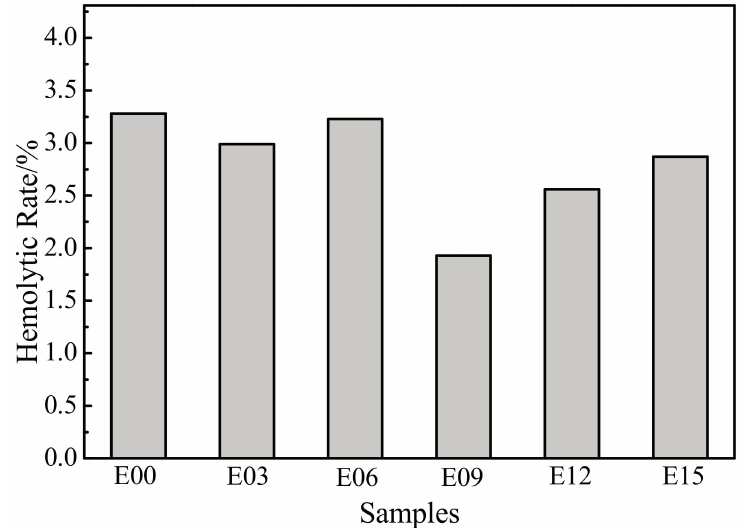
Figure 10. Hemolysis rate of samples. E00: substrate; E03: 3 min; E06: 6 min; E09: 9 min; E12: 12 min; and E15: 15